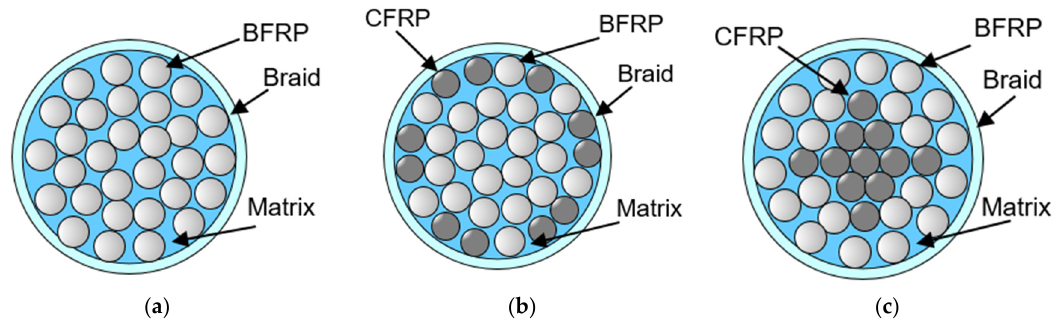
Figure 1. Cross-section types of a fiber reinforced polymer (FRP) bar: ( a ) Basalt FRP (BFRP) bar—only basalt rovings; ( b ) HFRP bar—carbon rovings at the surface of the cross-section; ( c ) HFRP bar—carbon rovings in the core of the cross-section.